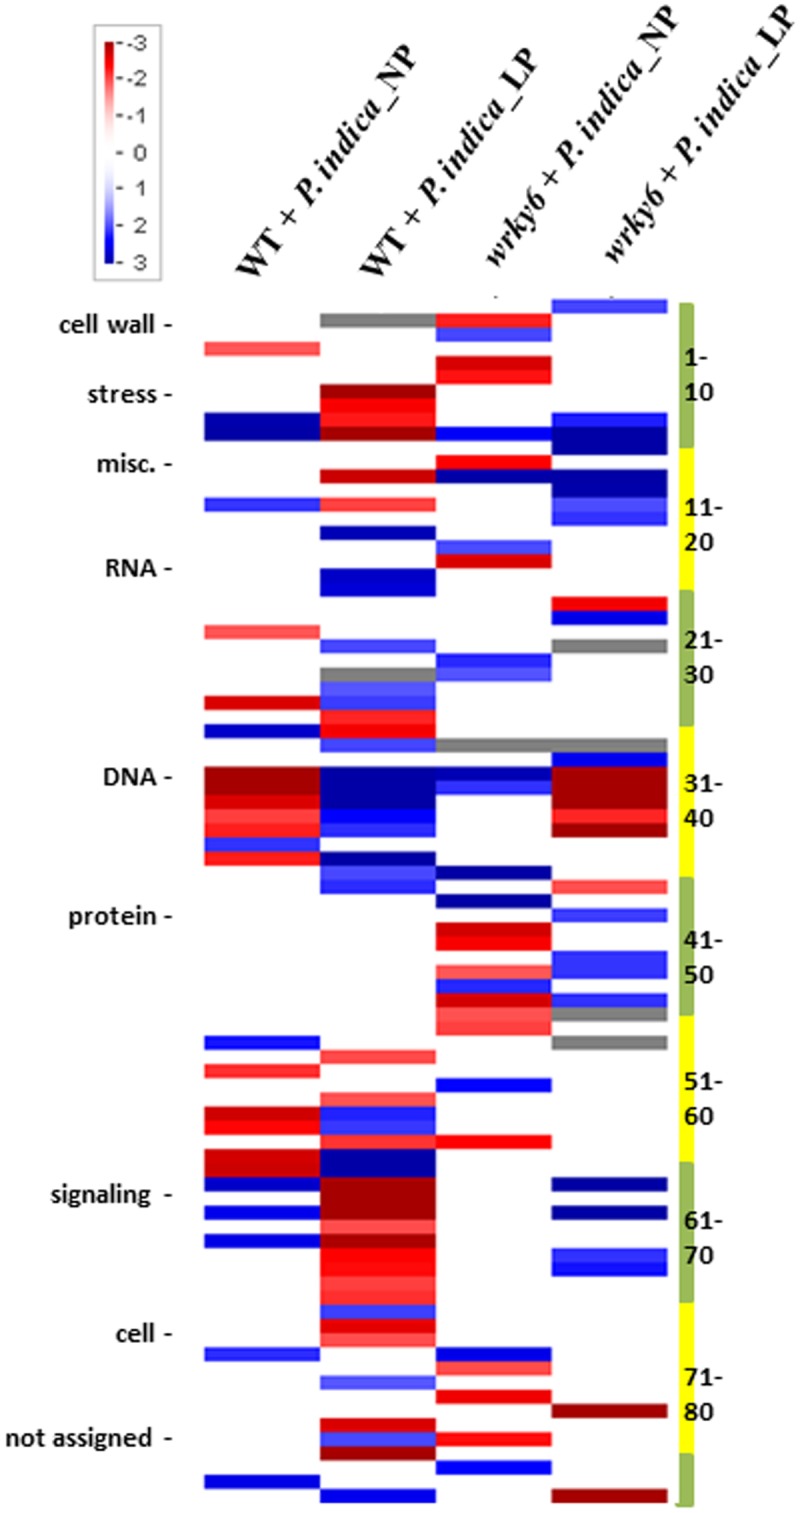
PageMan analysis of differentially expressed genes (>2-fold) by P. indica in WT or wrky6 roots grown on either NP or LP. Scale depicts level of expression with blue being high and red being low. Only significantly regulated (p-value <0.05) categories are shown. Numbers on the right refer to the categories defined by the PageMan program, which are presented in Supplementary Table S1. For specific genes, see data submitted to NCBI. For more detailed information on the program, cf. the MapMan software at http://mapman.gabipd.org/web/guest/mapman.